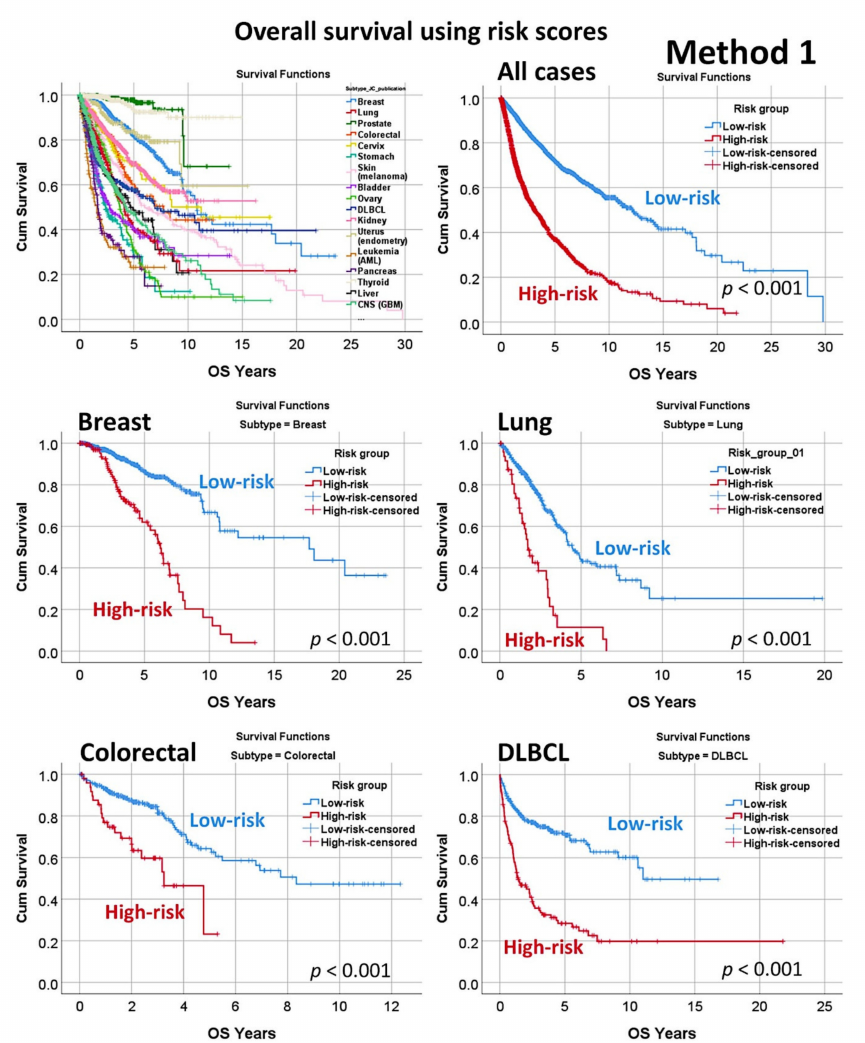
Figure 9. Overall survival in a pan-cancer series. The multilayer perceptron using the 20,862 genes identified a final set of 19 genes with prognostic value in mantle cell lymphoma. As a start point of the gene expression of the set of 19 genes and using a risk-score formula [36,46], we confirmed that these genes also contributed to the overall survival of diffuse large B-cell lymphoma (DLBCL). Additionally, these genes could also predict the overall survival of a pan-cancer series of 7289 cases from The Cancer Genome Atlas (TCGA) program that included the most frequent human cancers. Of note, the weight and direction of the overall survival association was different in each subtype of neoplasia. Risk scores were calculated by multiplying the beta values of the multivariate Cox regression analysis for overall survival of each gene with the values of the corresponding gene expressions, as previously described